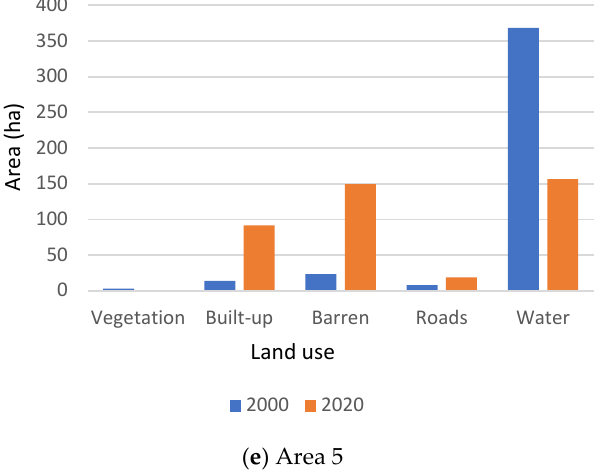
Figure 5. Comparative analysis of LULC in the five coastal areas in DMA, 2000–2020. In Area 1, 98.6% of the coastal sea area occupied by water in 2000 was reclaimed and transformed mainly into built-up and barren land in 2020. In Area 2, the whole seacoast area was reclaimed in 2020, and a major part of this reclaimed area was transformed into barren land. In Area 3, there was no coastal area. Otherwise, 66.5% of the area covered by whole coastal area in 2000 was reclaimed in 2020 and converted mainly to barren land. For Area 5, about 57.5% of the area occupied by water and 89% occupied by vegetation in 2000 were converted to built-up and barren land in